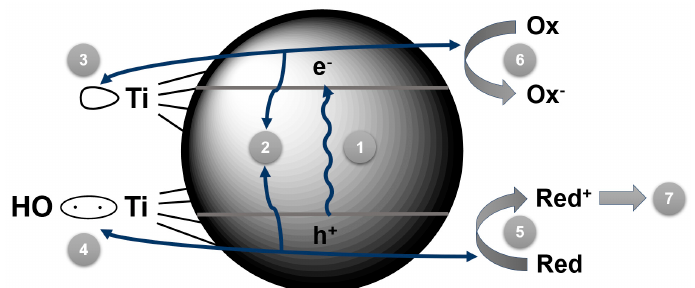
Figure 1. Primary steps in the mechanism of photocatalysis: ( 1 ) formation of charge carriers by photon absorption; ( 2 ) charge carrier recombination; ( 3 ) trapping of a conduction-band electron at a Ti(IV) site to yield Ti(III); ( 4 ) trapping of a valence-band hole at a superficial Ti–OH group; ( 5 ) initiation of an oxidative pathway by a valence-band hole; ( 6 ) initiation of a reductive pathway by a conduction-band electron; ( 7 ) further thermal (e.g., hydrolysis or active oxygen species-mediated reactions) and photocatalytic reactions to yield mineralization products. Adapted with permission from [8], American Chemical Society, 2014.